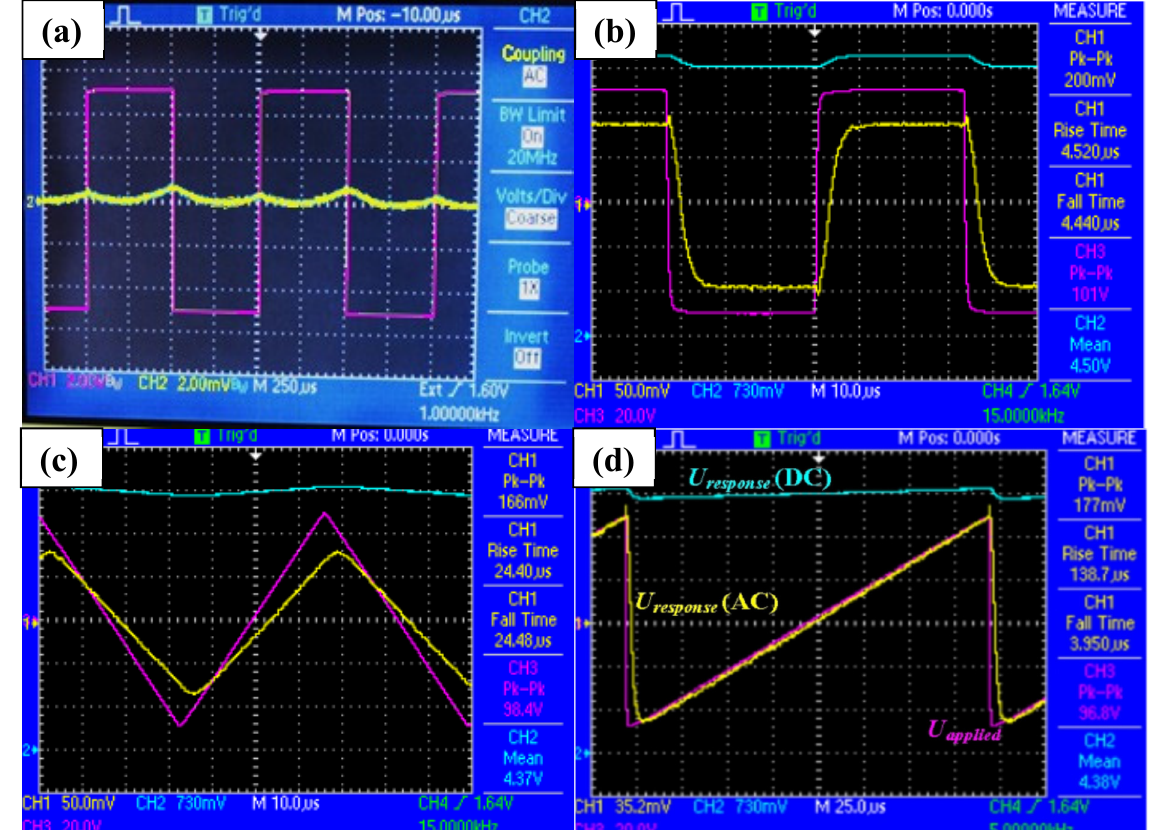
Figure 3. Oscillograms of the electro-optical response in the N and N X phases of M2. Channels: Magenta—applied voltage, Yellow—AC-coupled photodiode signal, Blue—DC-coupled photodiode signal. ( a ) The response from a planarly aligned cell in nematic phase, the amplitude of signal applied: 10 V peak to peak . The maximum output is ~ 1mV, arising presumably from the defects in an LC cell. ( b ) Square waveform of amplitude 101 V peak to peak applied to the cell in the N X phase, the output peak to peak : 200 mV, rise time (response signal rising from 10% to 90% of the final value) is 4.52 μ s. The fall time (response signal falling from 90% to 10%) is 4.40 μ s. The DC output mean voltage: 4.5 V, ( c ) the response of LC cell to a triangular waveform in the Nx phase: peak to peak input signal 38.4 V, output is a linear response of amplitude 166 mV peak to peak, DC component 4.37 V. ( d ) Response from a linear voltage sweep of 38 V applied, the output: linear, and peak to peak is 177 mV, fall time: 3.95 μ s.